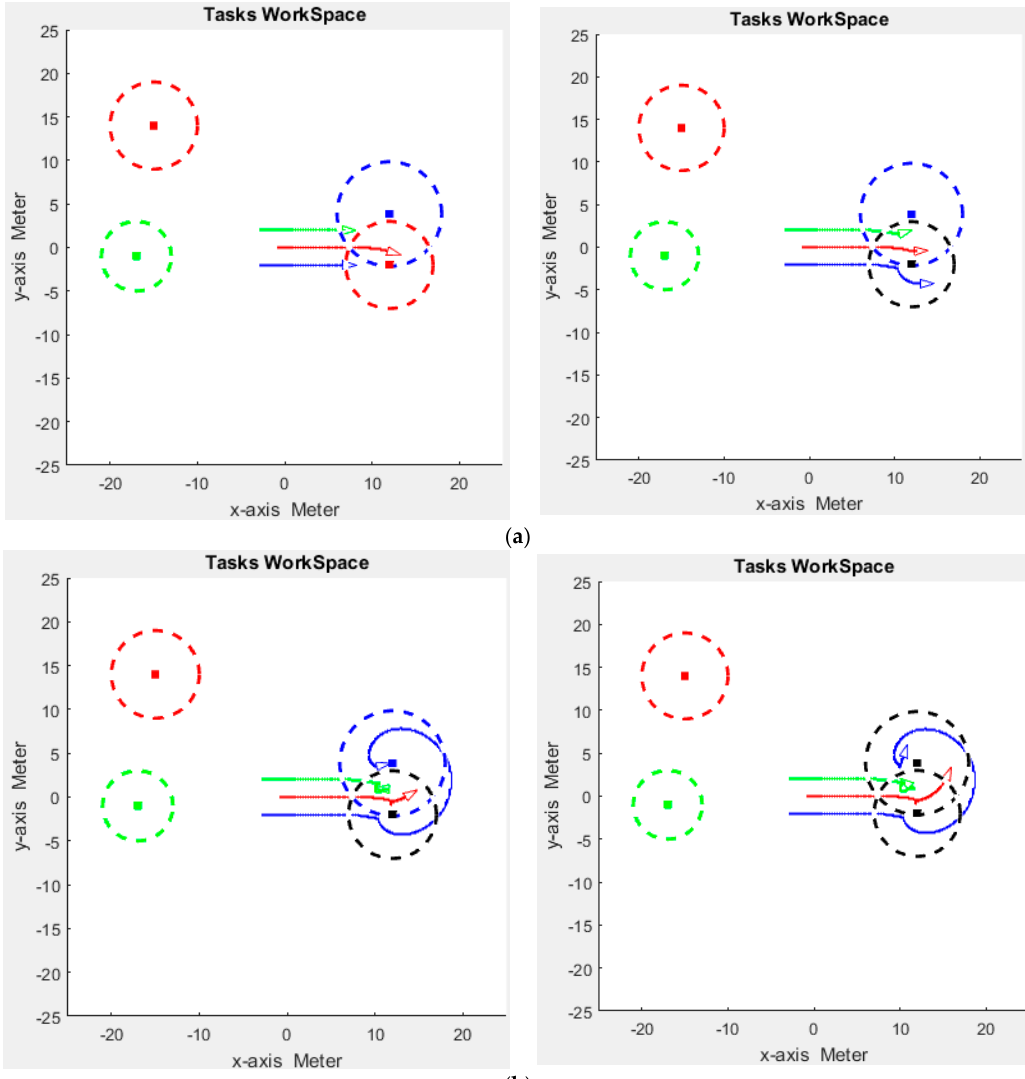
Figure 4. ( a ) Overlapping zones of influence with task 1 (red) selected as having priority which drives the red robot to become the leader until task completion; and ( b ): second priority task (blue) being performed with blue robot transitioned to leader